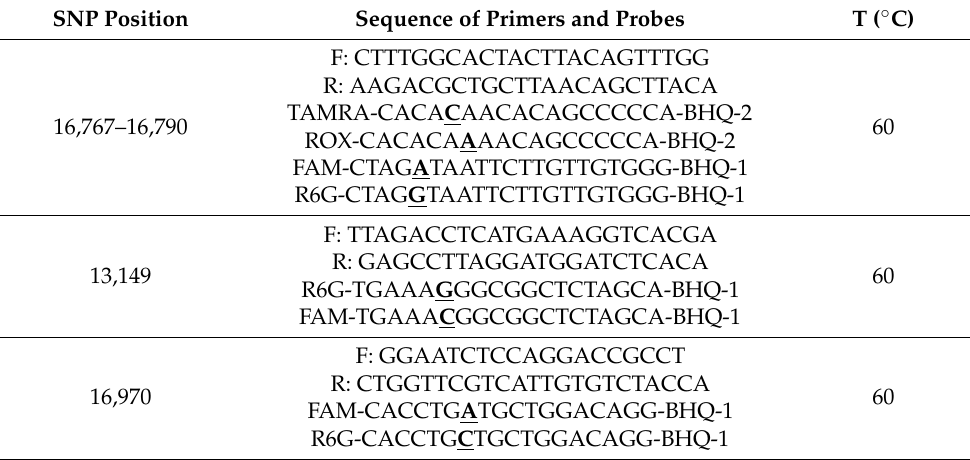
Table 1. Primers and probes for the analysis of regions of the DIO1 gene. SNP Position Sequence of Primers and Probes T ( ◦